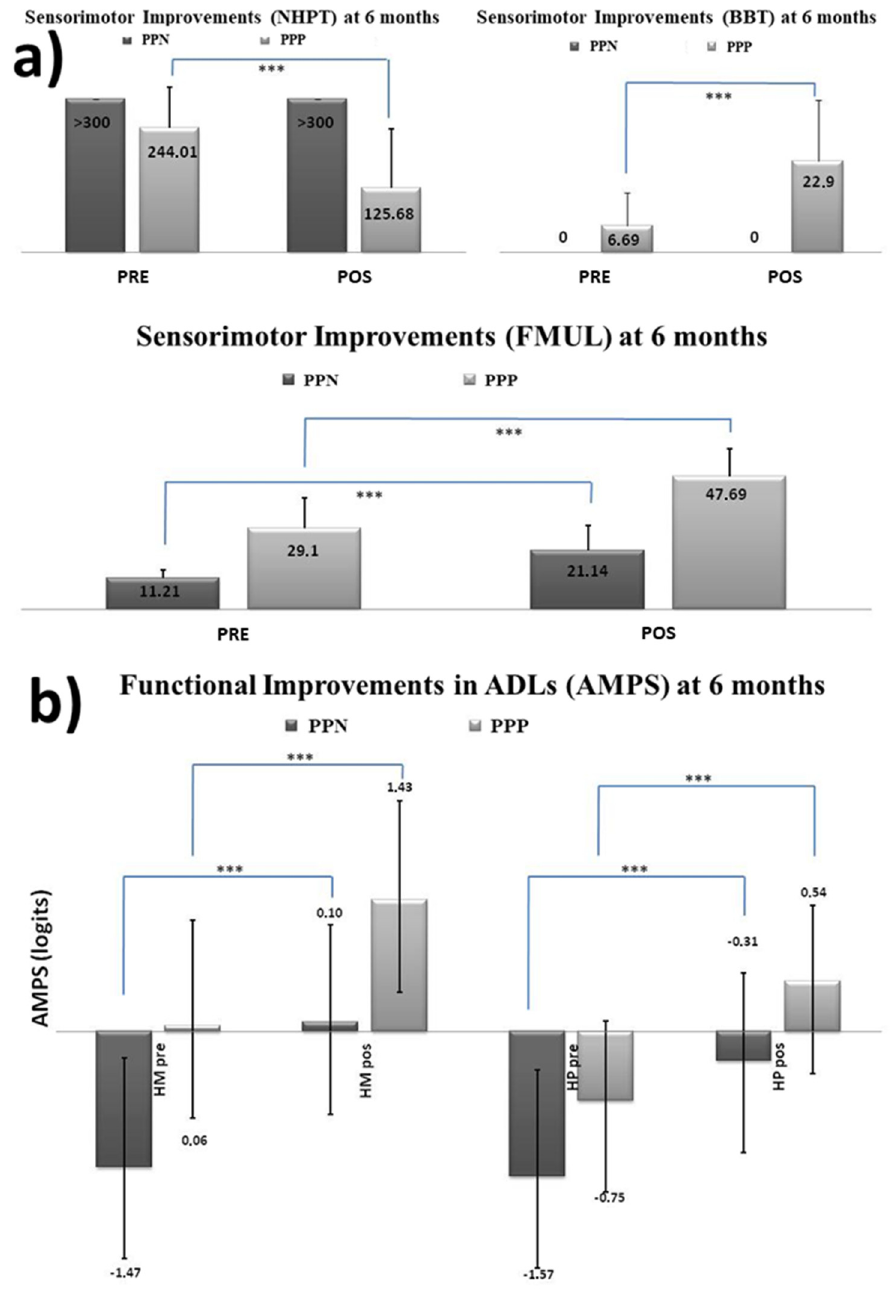
Figure 4. Sensorimotor ( a ) and functional ( b ) effects of the synergistic treatment (i.e., COHT + RAT) at 6 months in the outcome variables NHPT, BBT, FMUL and AMPS©. The FMUL scale showed a significant effect of the combined treatment for both prognosis groups (*** p < 0.001), while NHPT and BBT only detected it in the PPP group (*** p < 0.001).